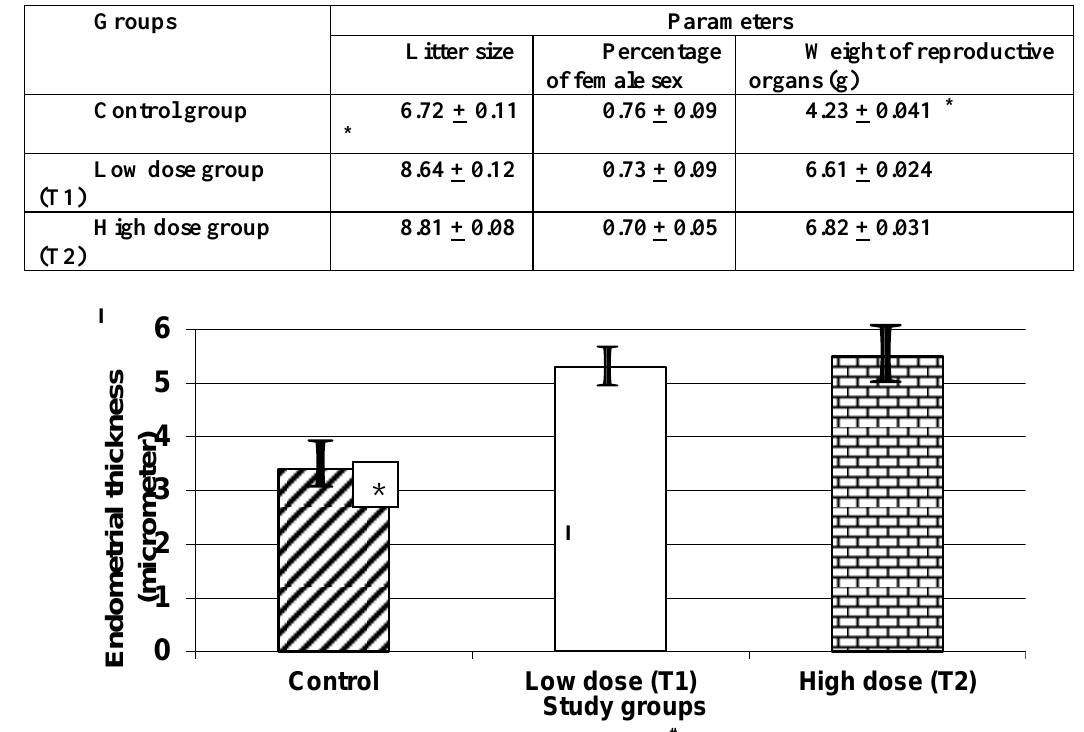
Figure 1: Endometrial thickness for pregnant mice # administered two doses of L-carnitine throughout pregnancy (No.=10 pregnant mice/group; Data are Mean+ S.E.) Table 2: Levels of serum FSH, LH and E for pregnant mice # administered two doses of L- 2 carnitine throughout pregnancy (No.=10 pregnant mice/group; Data are Mean+